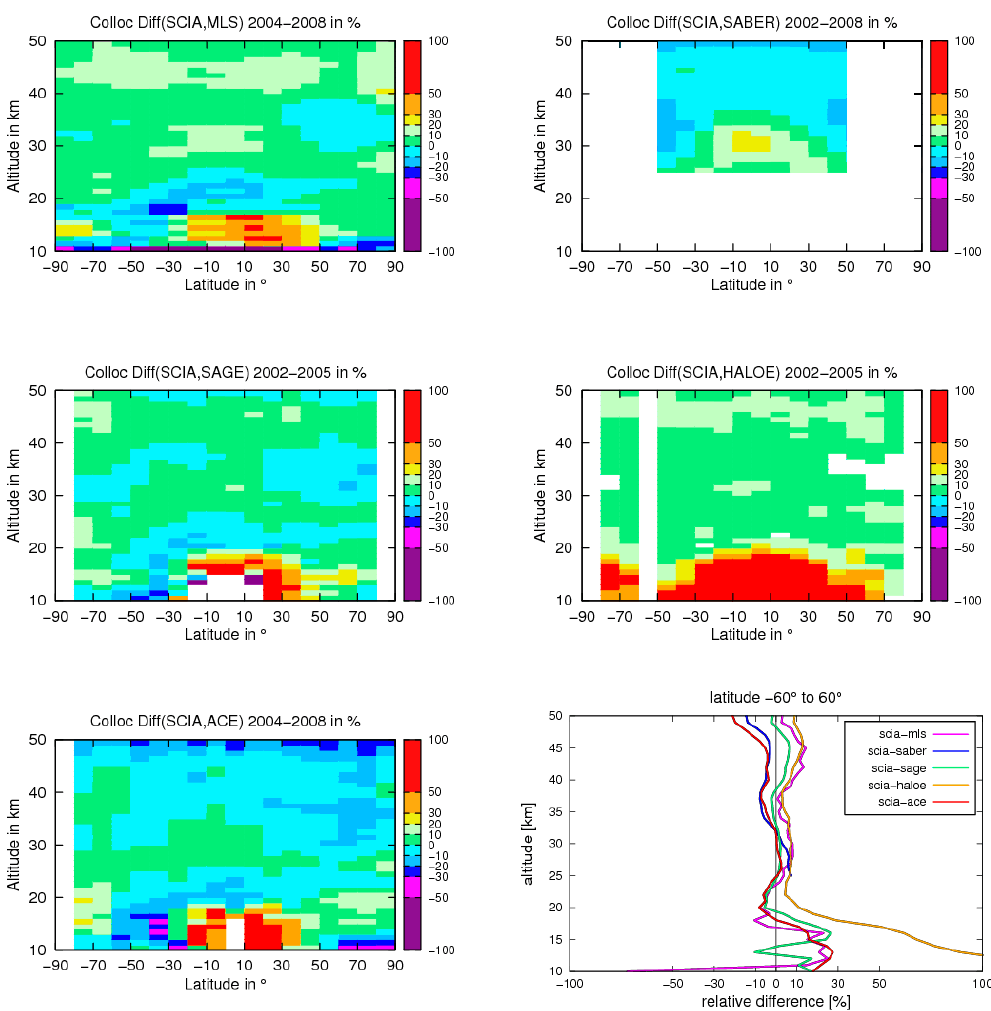
Fig. 3. Mean percent differences between SCIAMACHY and the other instruments, MLS, SABER, SAGE II, HALOE and ACE-FTS based on monthly means of collocated profiles. Collocation radius of 400km and maximum time difference of 4h, all instruments, and 24h, SABER